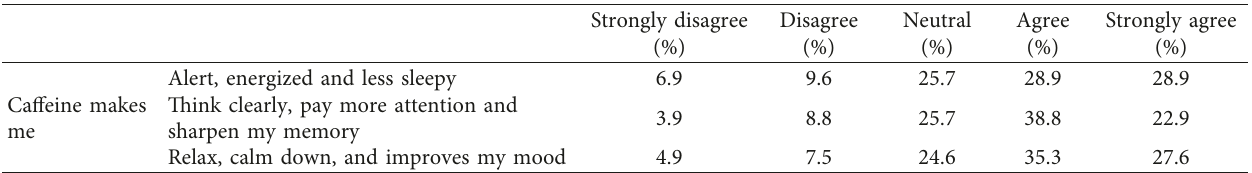
Table 5: Caffeine expectations.